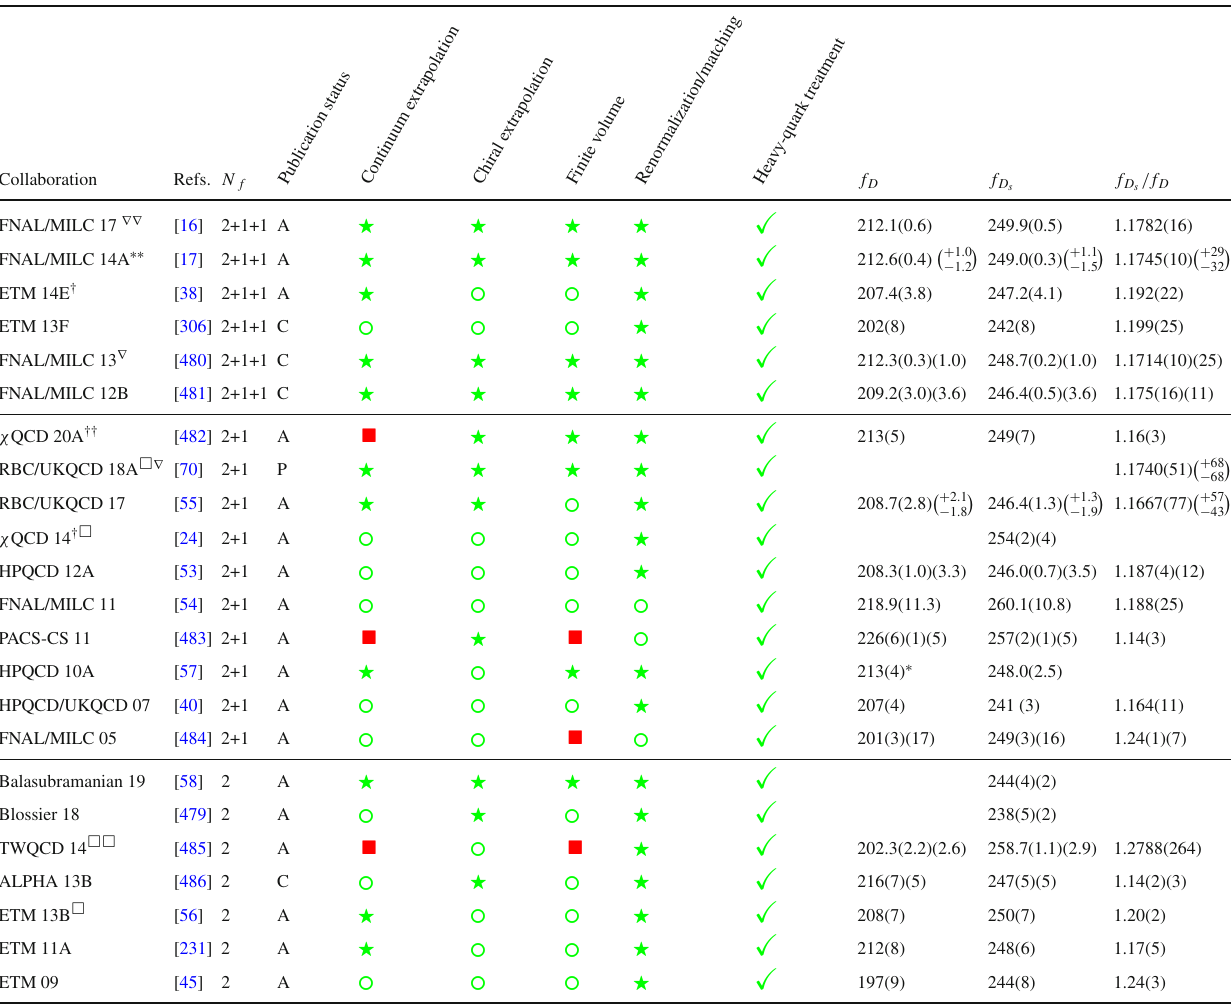
Table 34 Decay constants of the D and D s mesons (in MeV) and their ratio